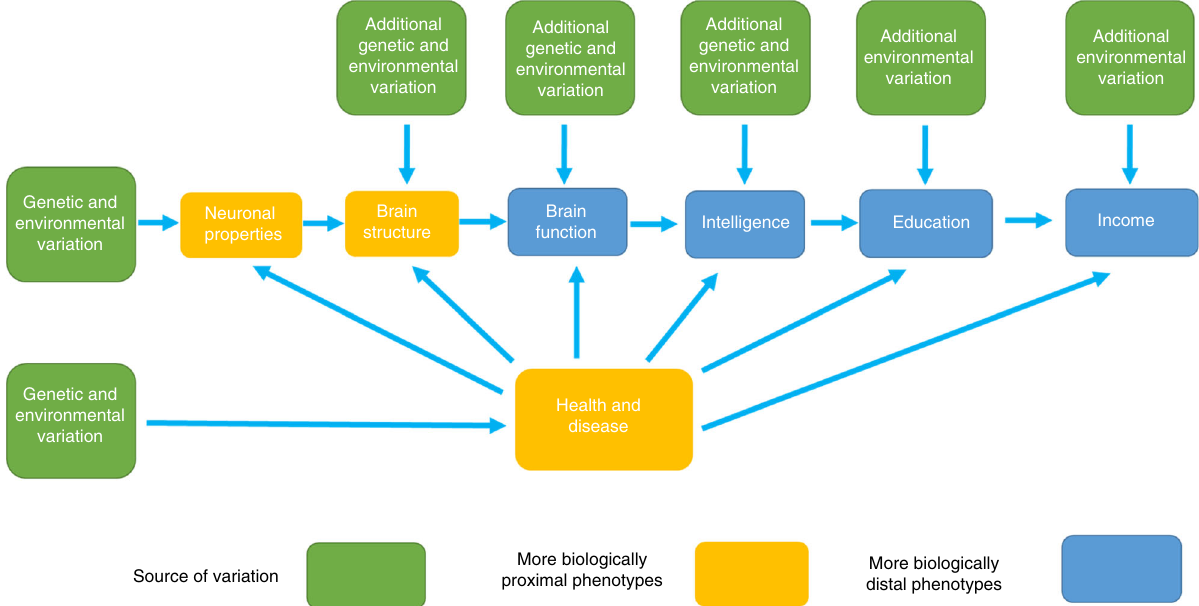
Fig. 1 Illustrating a possible pathway from genetic inheritance to income. In this pathway there are no direct effects of genetic variants on income. Rather, mediated pleiotropy (also termed vertical pleiotropy) is used to understand, in part, the link between genetic variation and more biologically distal phenotypes such as income and education. Mediated pleiotropy describes instances where genetic variation is linked to a phenotype (in this case income) through genetic effects that act on another partly heritable trait. These partly heritable traits would also be associated with income, and so the genetic effects that act on them would also be associated with income. For simplicity, this schematic illustrates only two possible pathways between genetic variation and income. In reality, there may be, and are likely to be, many links between genetic variation, including bidirectional causality between the phenotypes in the pathway, and the more biologically distal phenotypes such as